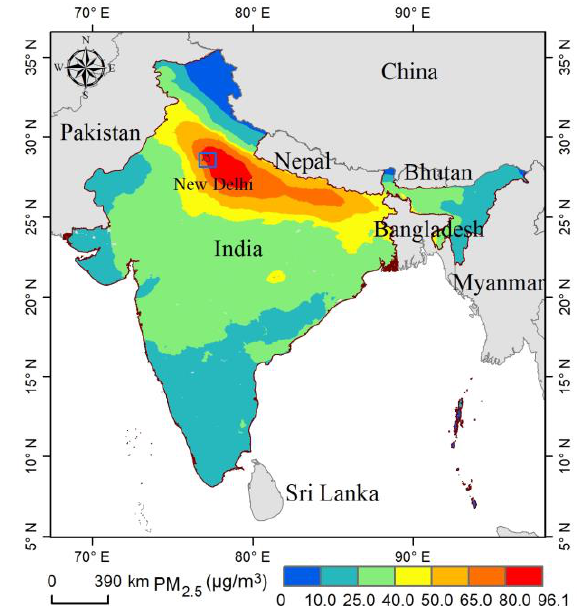
Figure 1. Spatial distribution of average PM 2.5 in India during